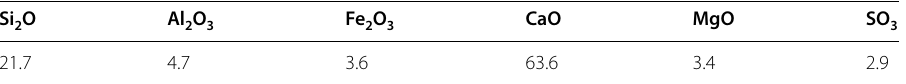
Table 2 The chemical composition (in percent) of cement agent used in mixtures Si 2 O Al 2 O